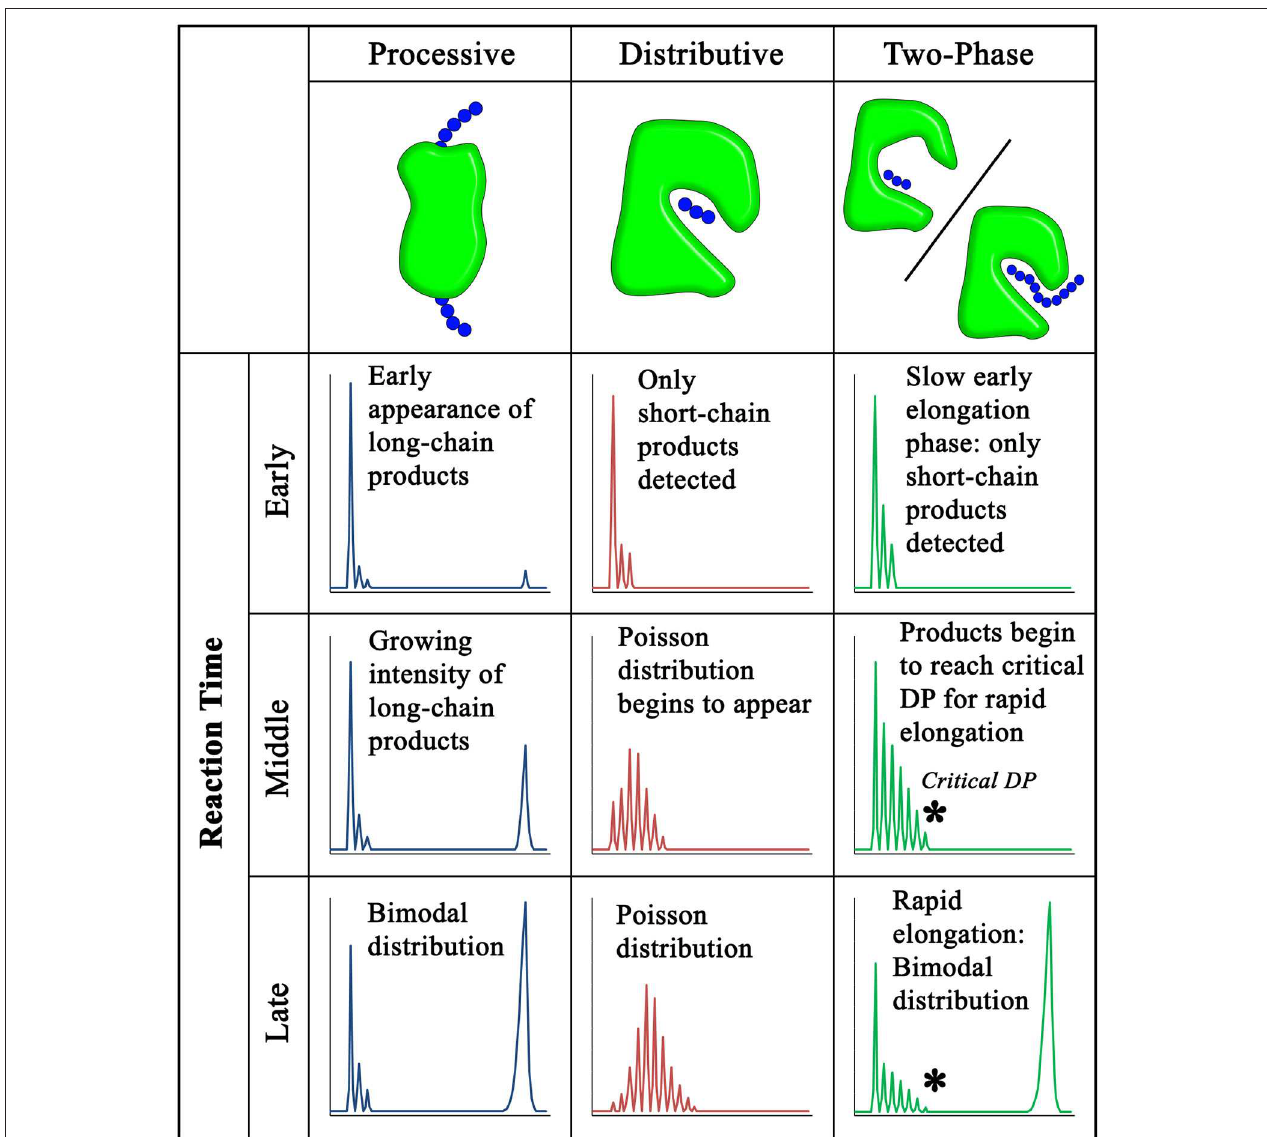
FIGURE 2 | Polysaccharide chain elongation patterns for processive, distributive, and two-phase distributive glycosyltransfer. Glycosyltransferases synthesize polysaccharides by different mechanisms that result in characteristic product profiles over the progress of an elongation reaction. The hypothetical product profiles shown correspond to the elongation of a short-chain acceptor (left) into longer-chain products (right). Three panels are shown for each proposed mechanism corresponding to the early, middle, and late stages of reaction progress. Product profiles are representative of several methods that are used to obtain chain length information, including HPLC, MALDI-MS, and polyacrylamide gel electrophoresis. In processive elongation, formation of an enzyme-substrate catalytic complex that is maintained through many rounds of monosaccharide transfer leads to a bimodal distribution of low and high MW products (Levengood et al., 2011; Raga-Carbajal et al., 2016). In distributive elongation, dissociation of the acceptor substrate following each round of addition and the lack of acceptor length bias leads to a Poisson distribution of products over time (Keys et al., 2014; Urbanowicz et al., 2014). A two-phase distributive mechanism accumulates short-chain products during the early phase of the reaction followed by rapid elongation of high MW polysaccharides resulting from large increases in catalytic efficiency for acceptors with chain lengths longer than a “Critical DP” (Vionnet and Vann, 2007; Amos et al., 2018). The product distribution of a two-phase distributive mechanism can resemble the bimodal distribution observed by processive glycosyltransferases. Chain length analysis may be suggestive of a particular elongation mechanism, but processivity cannot necessarily be inferred without direct evidence, such as the multi-TM translocation pore found in crystal structures of the BcsA:BscB cellulose synthase complex and proposed for other GT2-family structures (Morgan et al., 2013; Bi et al., 2015).